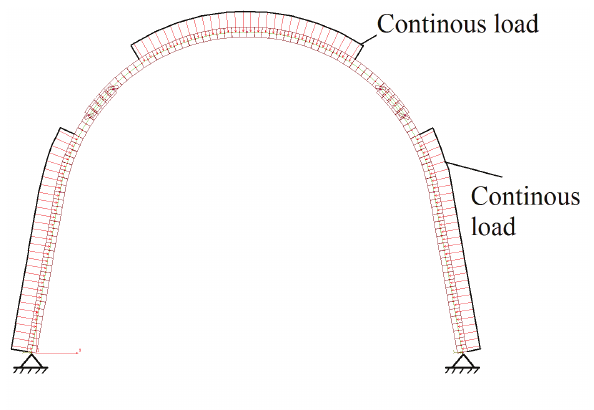
Table 4: Models analysed.